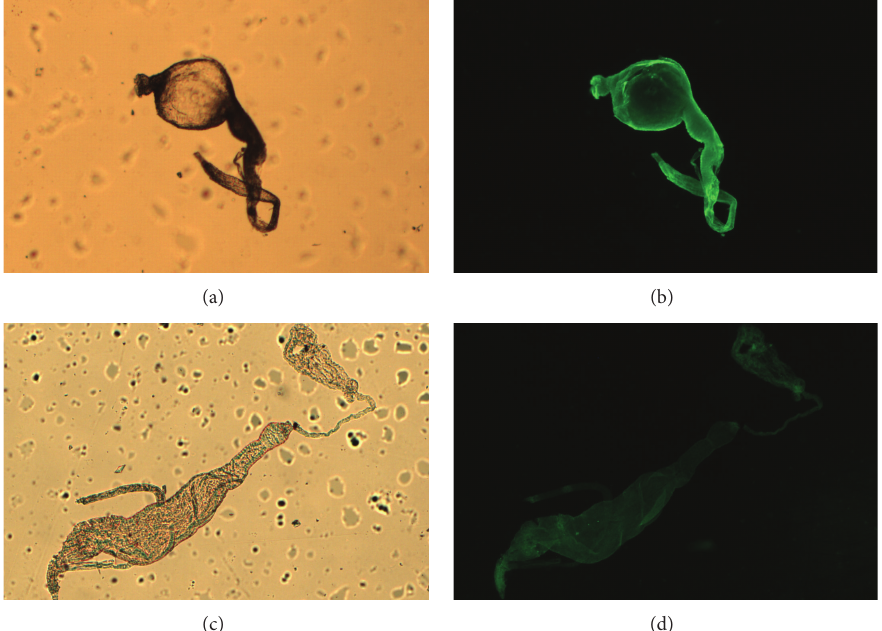
Figure 4: Bright field (a) and fluorescence (b) images of the FITC-DVL. The same images were acquired with the FITC-DVL blocked with D-mannose (c) and